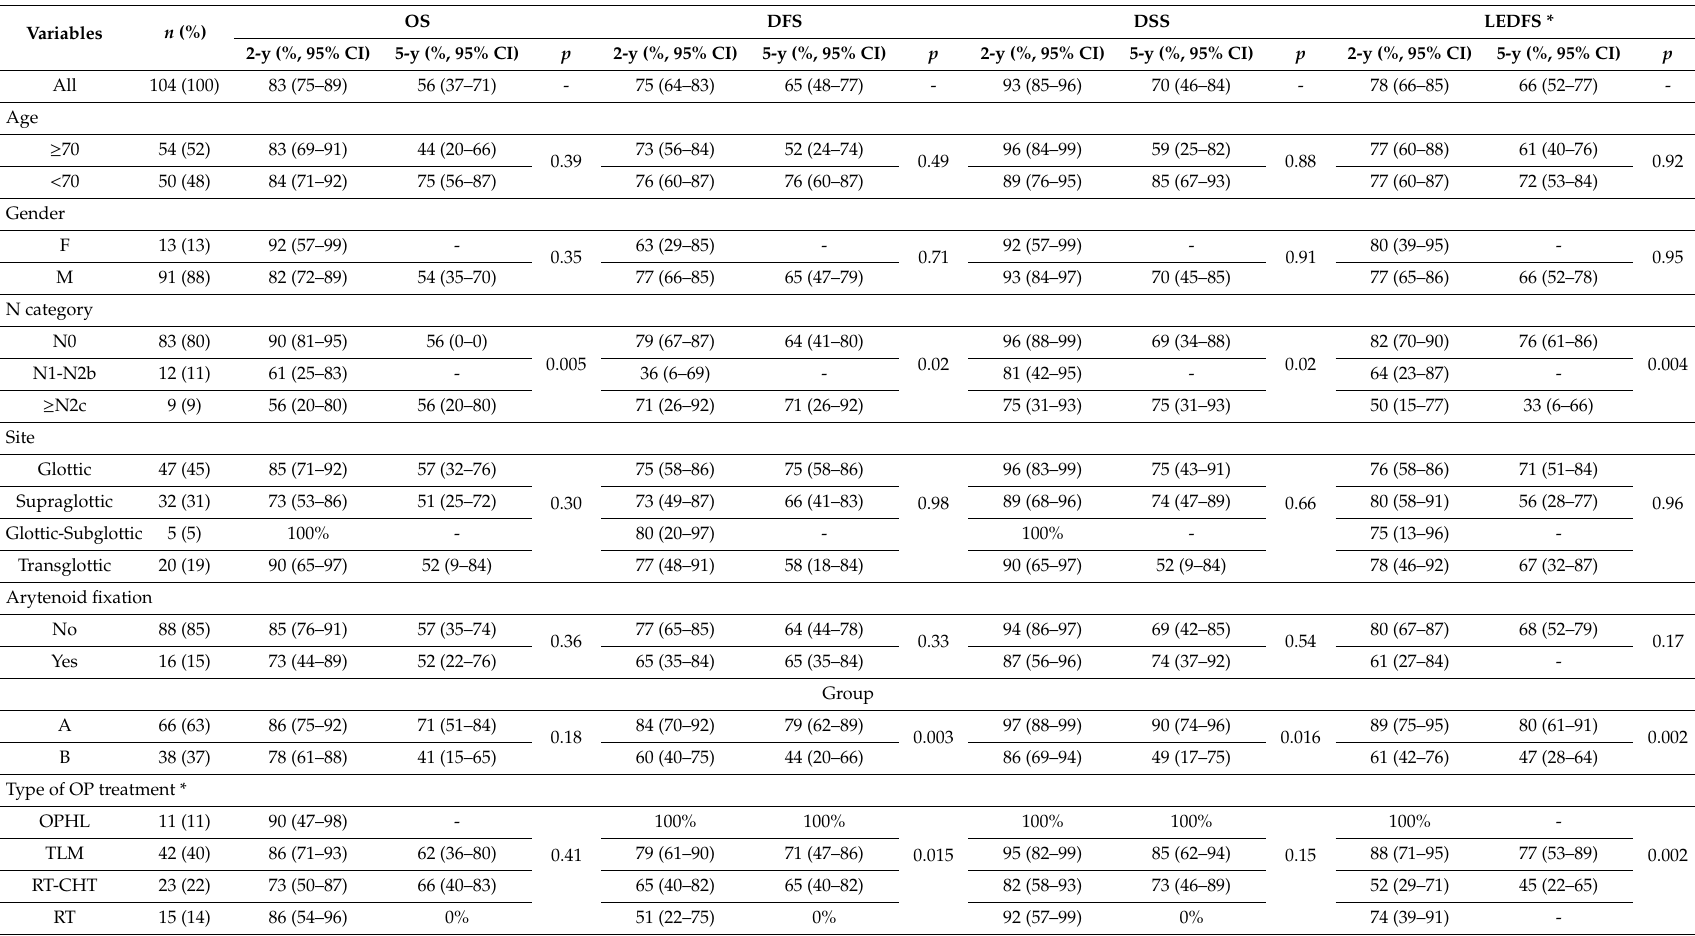
Table 2. Univariate survival analysis ( p values estimated by a log-rank